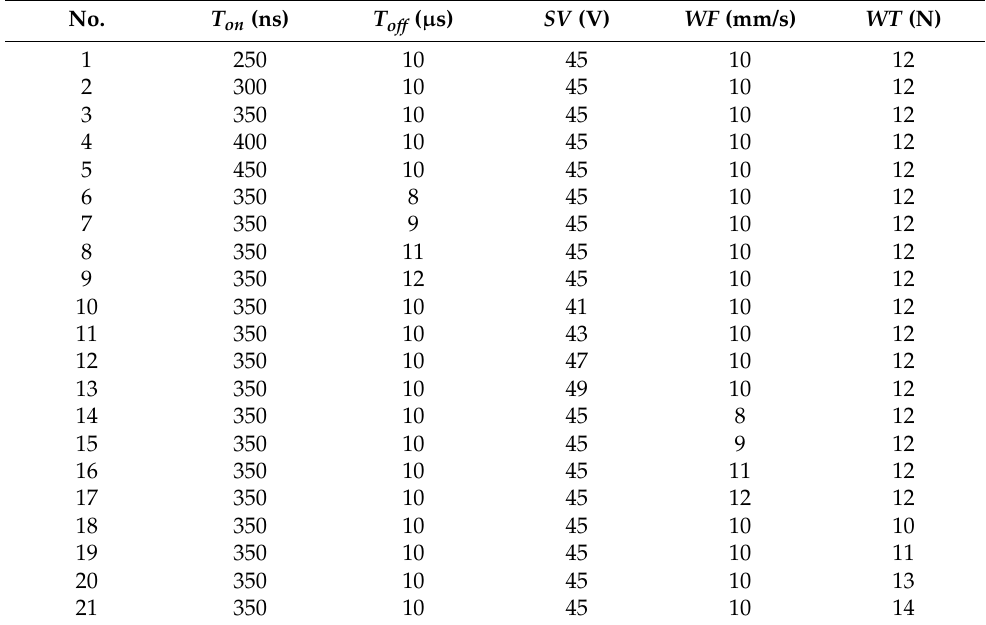
Table 3. The design of discharge cutting